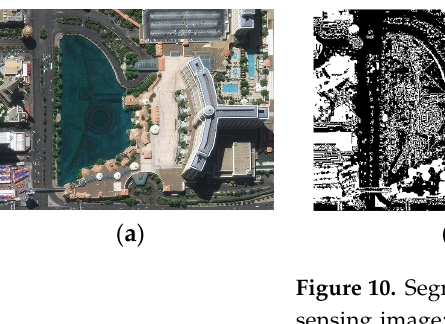
Figure 9. Segmentation results of IKONOS satellite remote sensing image 2: ( a ) original remote sensing image; ( b ) TPSCA–PCNN segmentation result; ( c ) PCNN segmentation result; ( d ) ELM segmentation result.